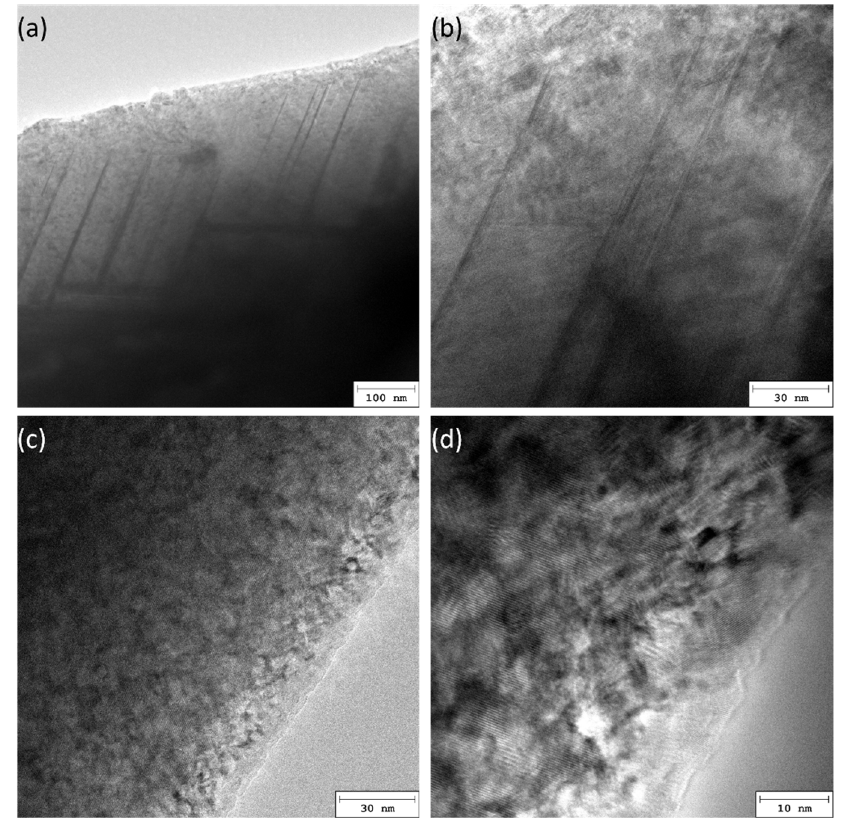
Figure 9. HTEM images of ( a , b ) CaNi 2 ( c , d ) Ca x Mg 1 − x Ni 2 ( x = 0.5) at high magnification.